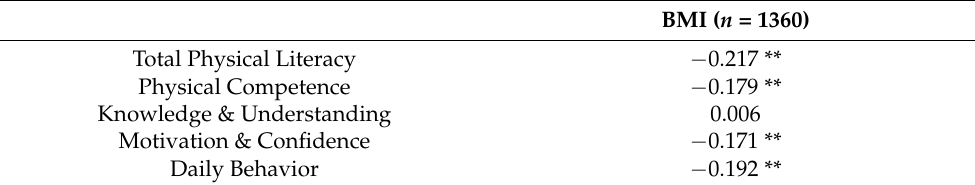
Table 5. Correlations between physical literacy and domain scores with body mass index (BMI).